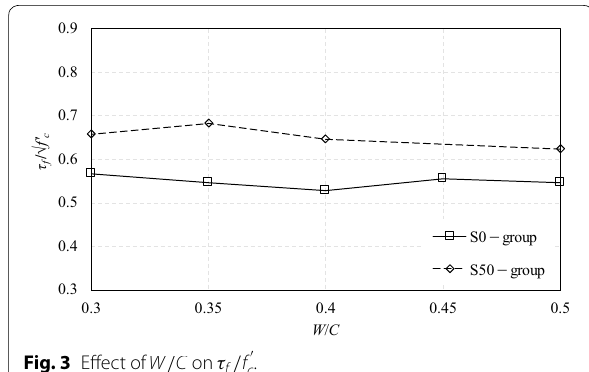
Fig. 3 Effect of W / C on τ f / f ′ c .